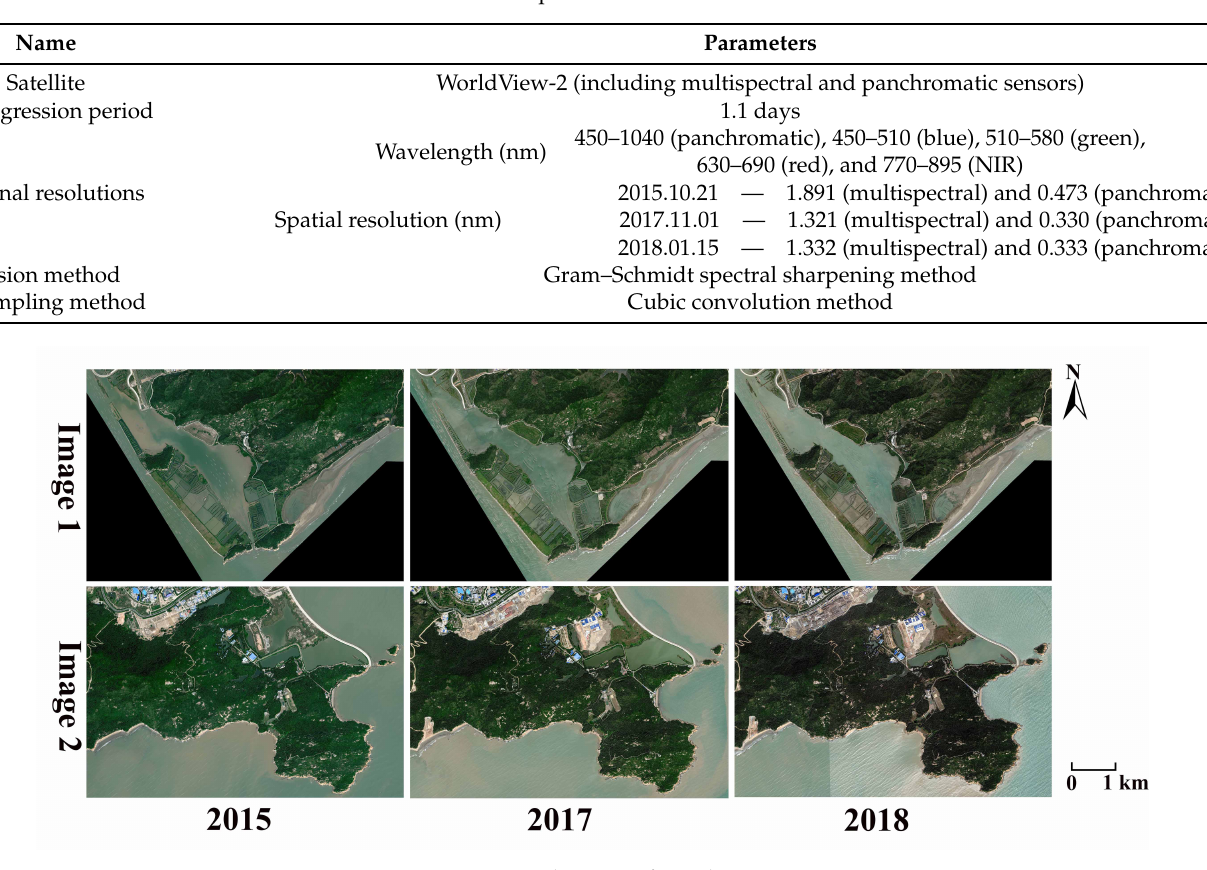
Figure 10. Research images from three